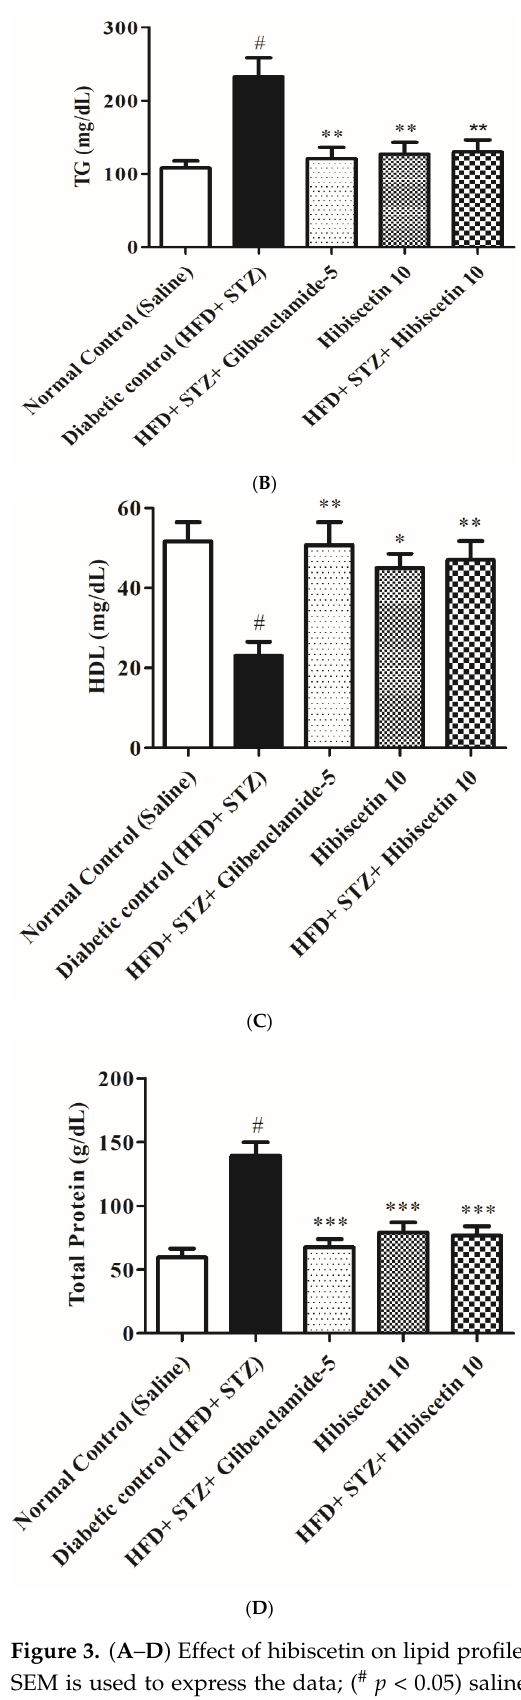
Figure 3. ( A – D ) Effect of hibiscetin on lipid profile ( A – C ) and total protein ( D ) (n = 6). The mean SEM is used to express the data; ( # p < 0.05) saline vs. HFD+STZ; (*** p < 0.001, ** p < 0.01, and * p < 0.05) HFD+STZ vs. treatment group.